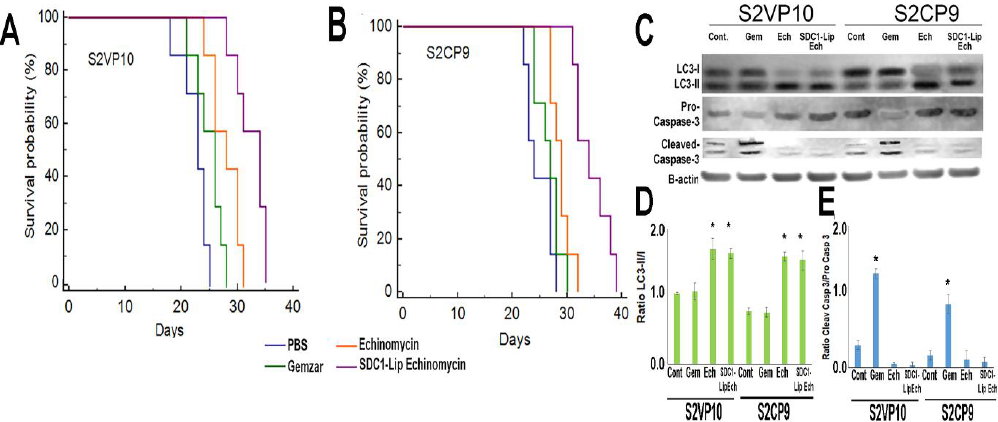
Figure 6. In vivo treatment of orthotopic pancreatic cancer with SDC1-Lip echinomycin. Mice were treated with Gemzar, echinomycin alone, or SDC1-Lip echinomycin weekly and survival was assessed. (A) In S2VP10 mice, echinomycin-only treatment was not significantly improved vs.